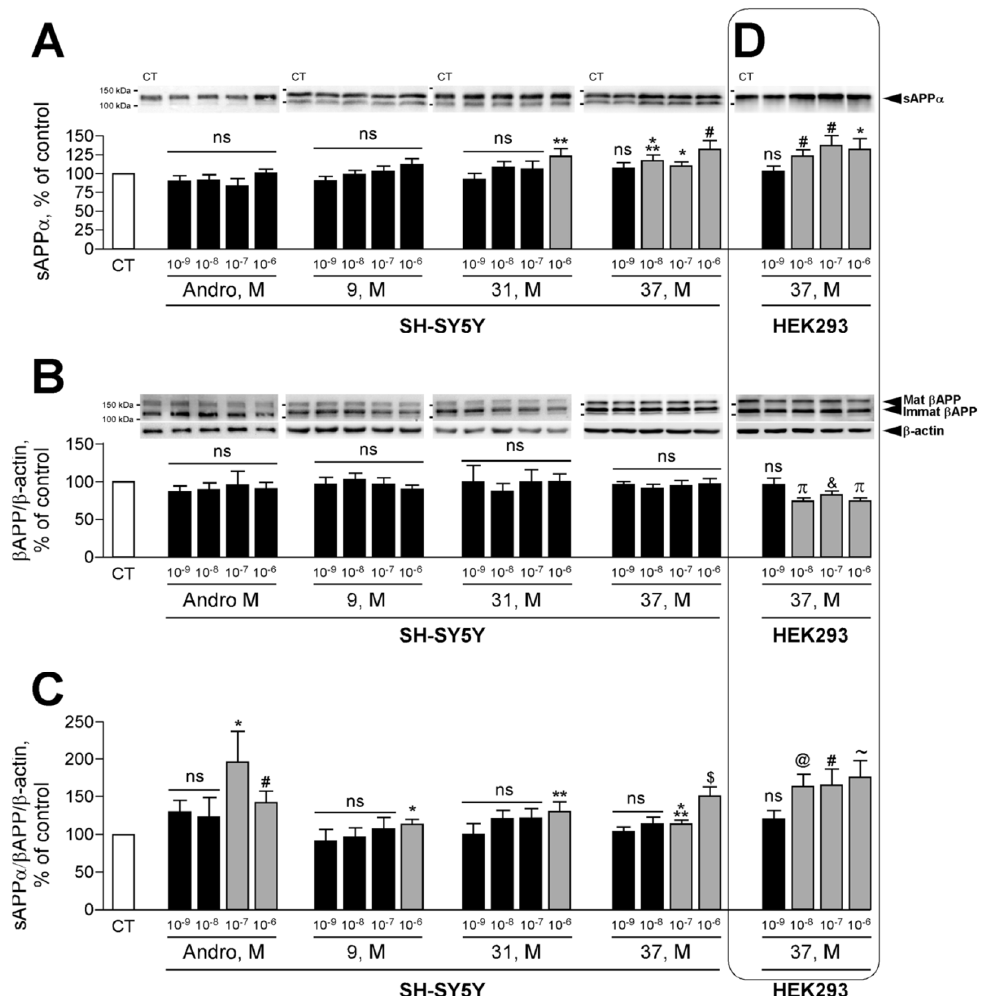
Figure 4. Effects of andrographolide and compounds 9 , 31 , and 37 at different doses on sAPP α secretion, β APP protein levels, and the ratio sAPP α / β APP in human cells. Data presented in ( A ) (sAPP α production), ( B ) ( β APP immunoreactivity normalized with β -actin), and ( C ) (ratio of sAPP α to β APP normalized with β -actin) are from experiments carried out in SH-SY5Y cells while data in ( D ) correspond to the results obtained for 37 in HEK293 cells. All bars are the densitometric analyses, are expressed as a percentage of control (white bars, non-treated cells) and are the means ± SE of 9 to 20 independent determinations. * p < 0.05; ** p < 0.03; *** p < 0.02; # p < 0.01; ~ p < 0.003; & p < 0.002; @ p < 0.001; $ p < 0.0002; π p < 0.0001 (gray bars); ns, no statistical difference (black bars). The upper parts of each panel illustrate representative gels.